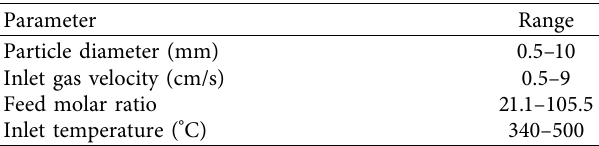
Figure 6: Concentration profiles in the catalyst pellet. Table 5: Process parameter